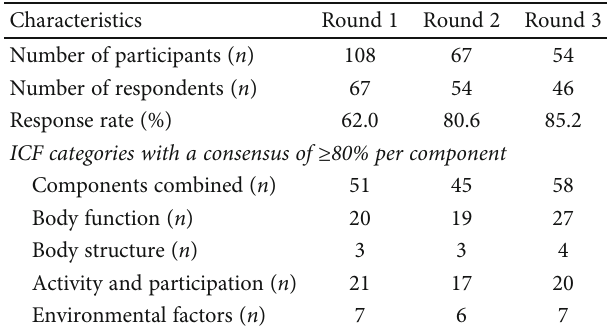
Table 1: Characteristics of the participants who answered in all Delphi rounds ( n = 46 ).